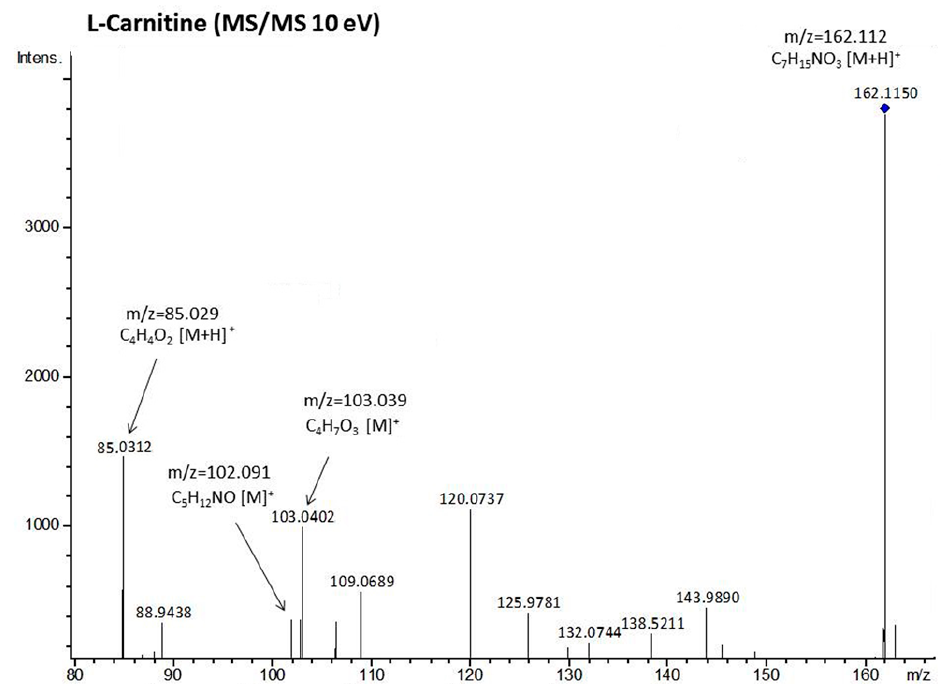
Figure 2. The results of tandem mass spectrometry (MS/MS) fragmentation of selected metabolites ( m / z —162,1150). MS/MS spectra obtained in positive ionization mode. Collision energy—10 eV. Reference m / z value of fragments of l-carnitine, chemical formula and ion type (taken from the public metabolite database) are also indicated in the figure.